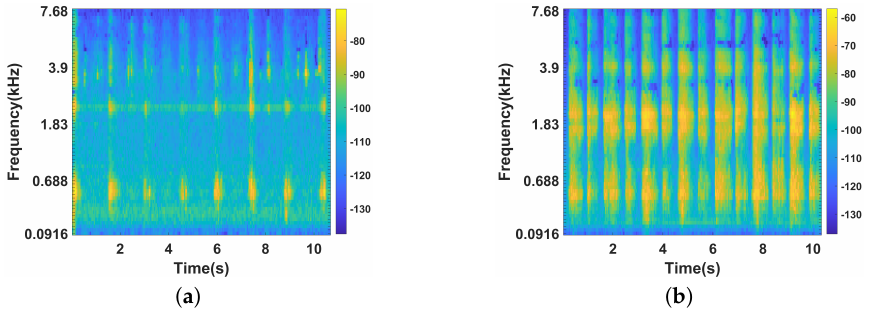
Figure 7. Comparison of breathing sound spectrograms at different exercise intensities. ( a ) Low exercise intensity. ( b ) High exercise intensity.